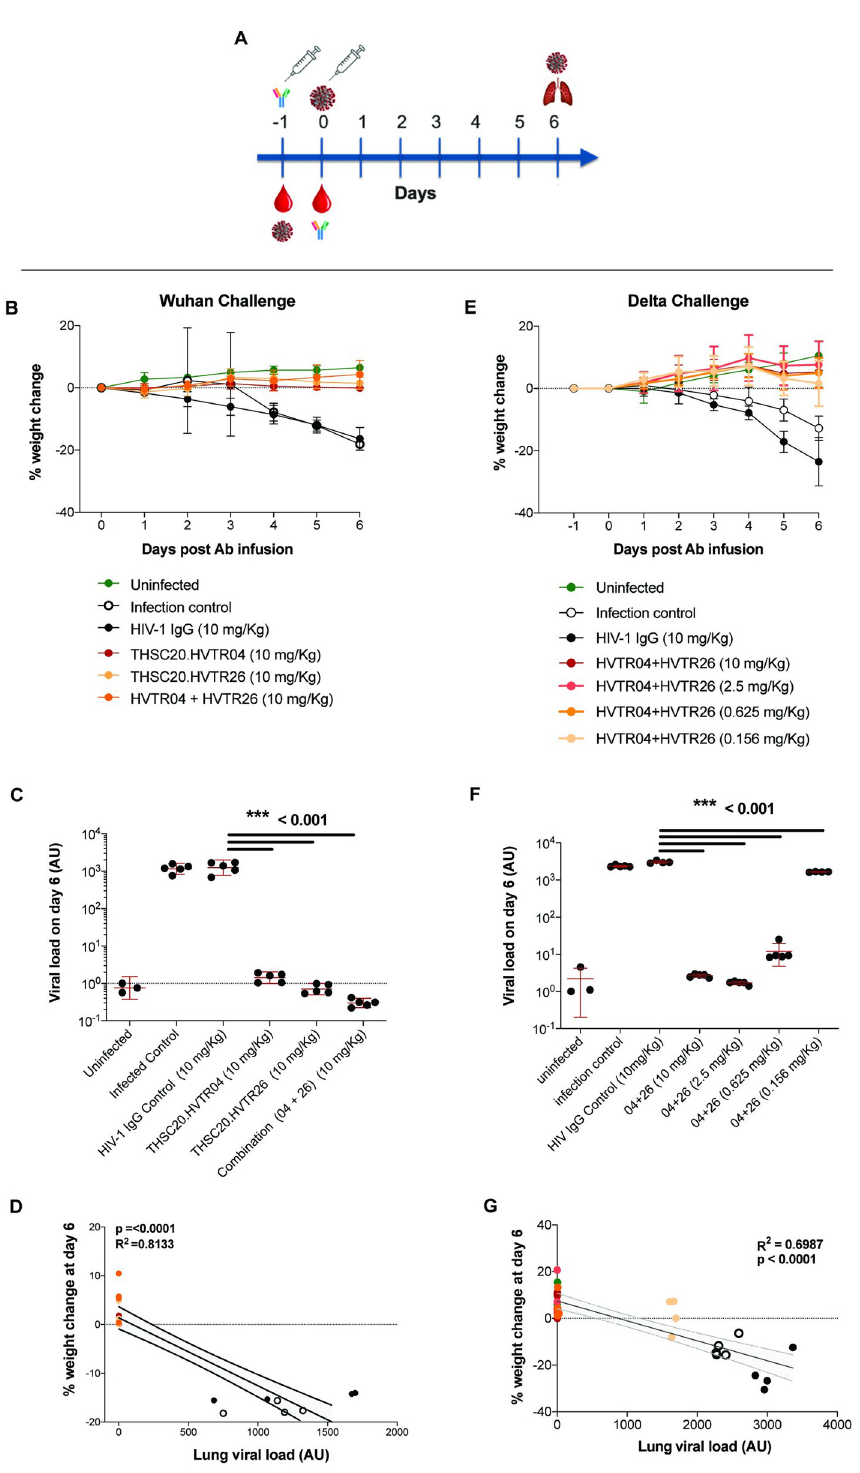
Fig 7. Neutralizing mAbs are able to protect against Wuhan and Delta variants in K18-hACE2 mice model. A. Experimental design of the efficacy assessment in K18-hACE2 transgenic mice model. K18-hACE2 mice were passively given intraperitoneal injection of the two individual mAbs or mixture of two mAbs 24 h prior to intranasal inoculation with 10 5 PFU of SARS-CoV-2 Wuhan or Delta isolate. Each mouse was administered with single dose of 10 mg/kg body weight (equivalent to 200 ug /animal) for testing against Wuhan isolate and four different doses of 10